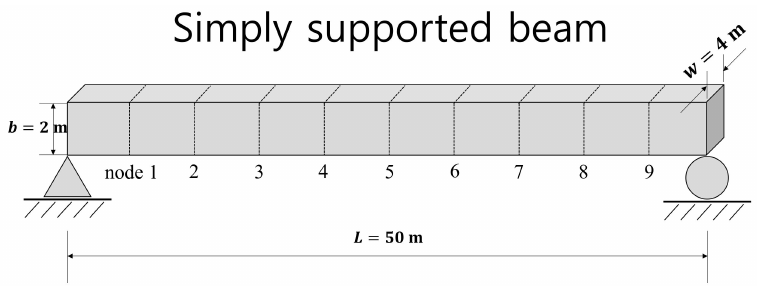
Figure 4. Simply supported beam for numerical validation.